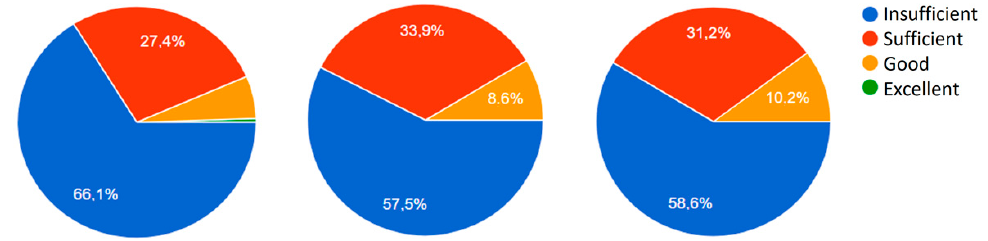
Figure 6. Degree of infrastructural networks between Viterbo at local (left), regional (centre) and national scale (right).